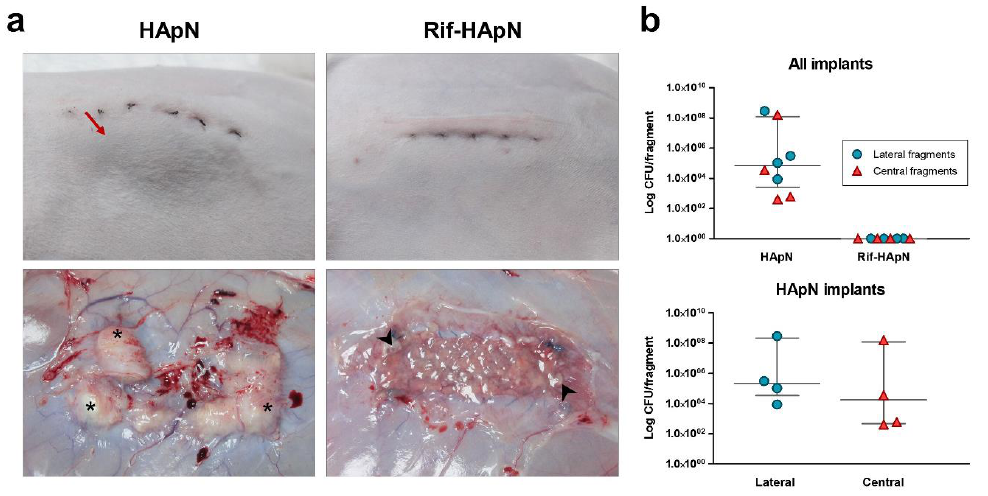
Figure 4. Response of the meshes to infection following 14 days of the bacterial challenge. ( a ) The HApN group evidenced bulges under the skin incision ( ) and large amounts of purulent material deposits (*), while Rif-HApN only showed a discrete presence of hydrogel remnant ( ) at the implant margins. ( b ) Sonication of tissue samples yielded no living bacteria in the Rif-HApN implants, while HApN were strongly colonized by Sa. In HApN group, no differences were observed between the bacterial yields from the lateral and central fragments. For each group, symbols depict the samples tested and grey lines represent the median and interquartile range.